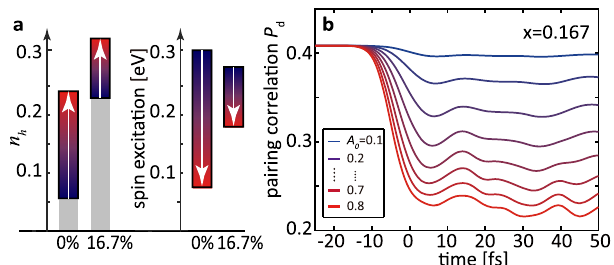
Fig. 4 Pump-induced modi fi cation of spin excitation energy and pairing correlations. a Equilibrium (gray) and maximal transient (colored) change of hole concentration and spin excitation energy (extracted from time- conditions in panel Fig. 3 at half- fi lling and 16.7% hole doping,